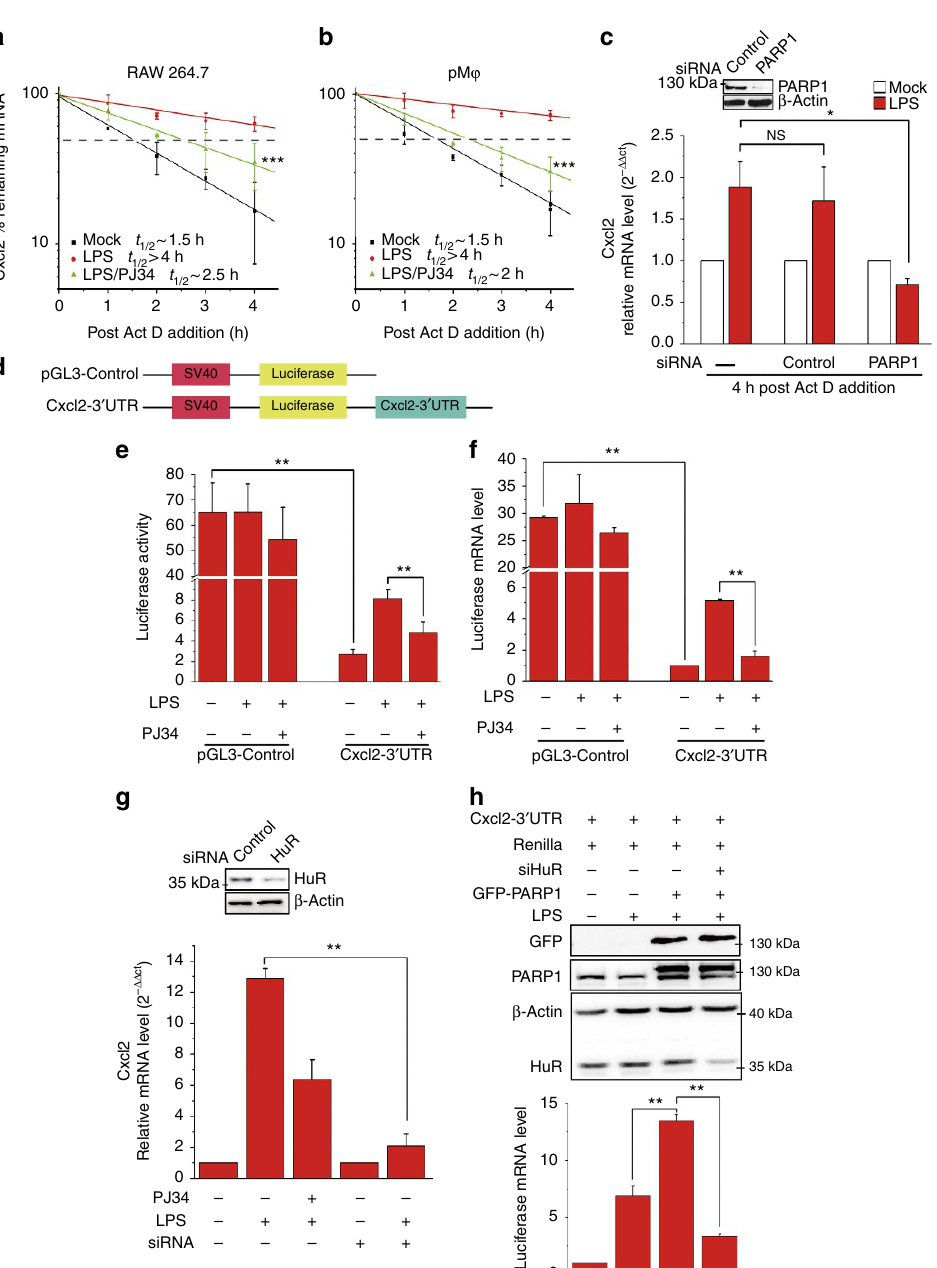
Figure 1 | PARP1 augments Cxcl2 expression at the post-transcriptional level via HuR. ( a , b ) PARP1 activity is essential for the increase in Cxcl2 mRNA half-lives in LPS-exposed macrophages. RAW 264.7 and pM j cells were exposed to LPS for 1h and then subjected to transcriptional inhibition with or without LPS maintenance ( ± PJ34) for various lengths of time as indicated. Real-time PCR was performed to assess the remaining Cxcl2 mRNA levels. The half-lives of different samples are indicated in the inset. A two-way analysis of variance (ANOVA) indicated the significance between the LPS/PJ34 and LPS groups at *** P o 0.001. ( c ) The depletion of PARP1 decreases Cxcl2 mRNA stability. RAW 264.7 cells were transfected with PARP1 or control siRNA, and 48h later, they were exposed to LPS and subjected to transcriptional inhibition with or without LPS maintenance ( ± PJ34) for 4h. Real-time PCR was used to assess the remaining Cxcl2 mRNA levels. ( d ) Diagram of the Cxcl2 -3 0 -UTR reporter plasmid construct. ( e , f ) PARP1 regulates Cxcl2 mRNA stability through its 3 0 -UTR. RAW 264.7 cells were transfected with reporter plasmids containing the Cxcl2 -3 0 -UTR or vector pGL3-control plus the Renilla reporter plasmid, and then challenged with LPS for 5h. Luciferase activity ( e ) and its mRNA levels were analysed by real-time PCR ( f ). ( g ) HuR is involved in the increase in Cxcl2 mRNA level induced by LPS stimulation. RAW 264.7 cells were transfected with siRNA targeting HuR or the control, and then challenged with LPS for 5h. Cxcl2 mRNA levels were determined by real-time PCR. ( h ) HuR mediates the role of PARP1 in mRNA stabilization. HEK 293 cells were subjected to HuR silencing, or not, and then co-transfected with the above-mentioned Cxcl2 -3 0 -UTR dual-reporter system with or without the GFP-PARP1 plasmid. Cells were cultured normally and challenged with or without LPS. The levels of luciferase mRNA were determined by real-time PCR using Renilla luciferase mRNA for calibration. Data were expressed as mean ± s.d. ( n ¼ 5), and analysed by one-way ANOVA. * P o 0.05, ** P o 0.01, NS, not